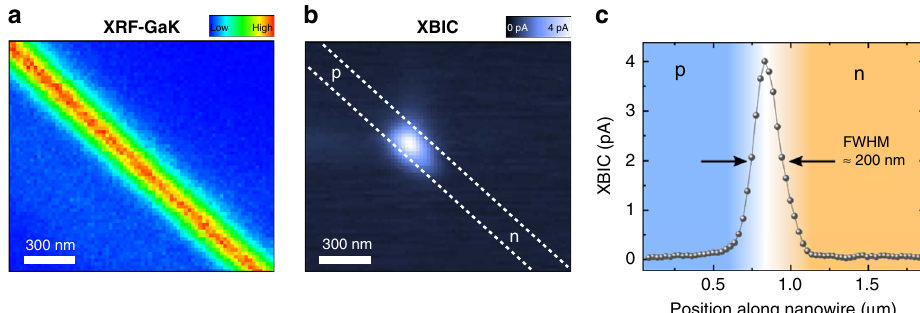
Fig. 2 Simultaneous detection of nano XRF and nano XBIC. a X-ray fl uorescence (XRF) map of a GaAs nanowire depicting the Ga K α line intensity measured with an incident X-ray energy of 11.9 keV, i.e., above the Ga and As K-edges. b The corresponding X-ray beam induced current (XBIC) signal at 0 V bias voltage measured simultaneously. The GaAs nanowire (as located in the Ga map) is indicated by the dashed, white lines. c Line scan along the nanowire axis of the XBIC signal.